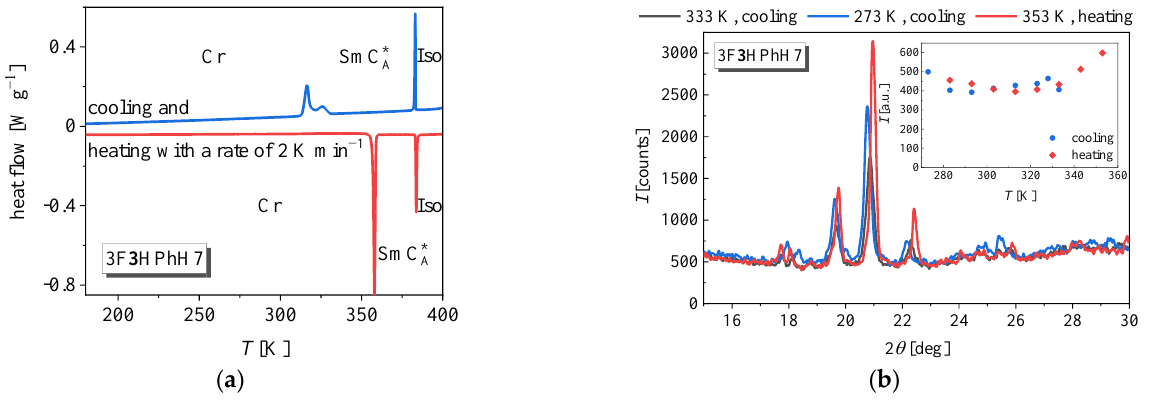
Figure 4. DSC curves of 3F 3 HPhH7 collected for slow cooling/heating ( a ). XRD patterns collected at the crystal phase upon slow cooling at 303 K and 273 K as well as upon slow heating at 353 K ( b ). The inset shows the temperature dependence of the integral intensity of the strongest peak of the crystal phase at 2 θ = 20.8°.